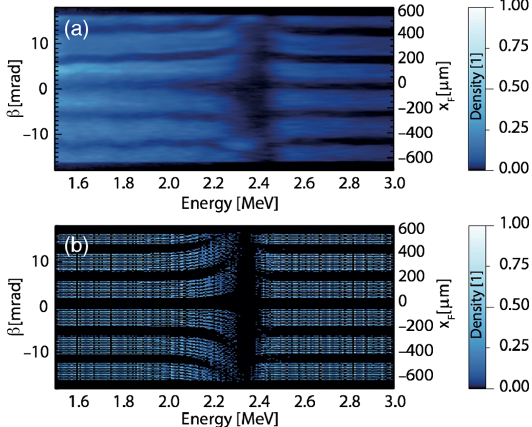
FIG. 6. Measured deflectogram (a) in longitudinal probing geometry and model simulation (b) with an unrealistic high electron temperature of 13 MeV and other adapted parameters (model C variation without temporal development of the Debye